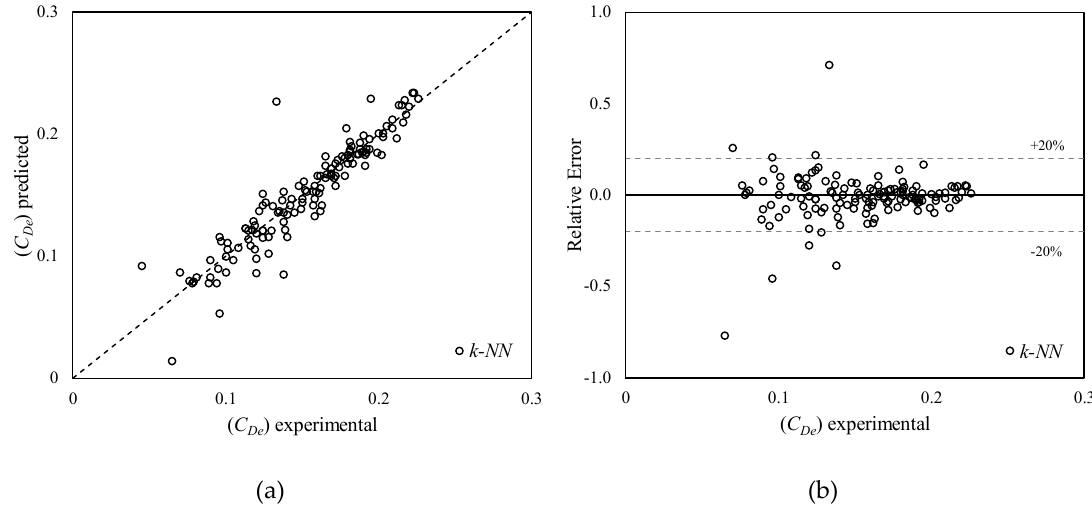
Figure 4. Model 1, k-NN algorithm, ( a ) predicted versus experimental results, and ( b ) relative error versus experimental results.